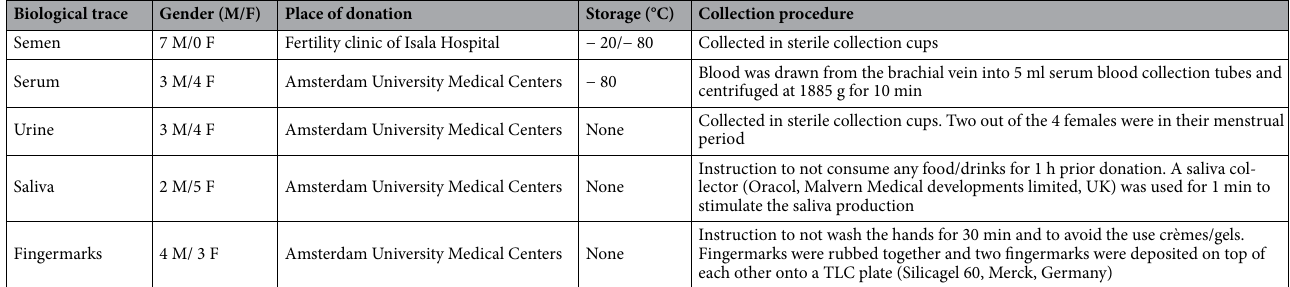
Table 2. Details of the donation procedure of semen, serum, urine, saliva and fingermarks from seven healthy donors. M presents male donors and F female donors.